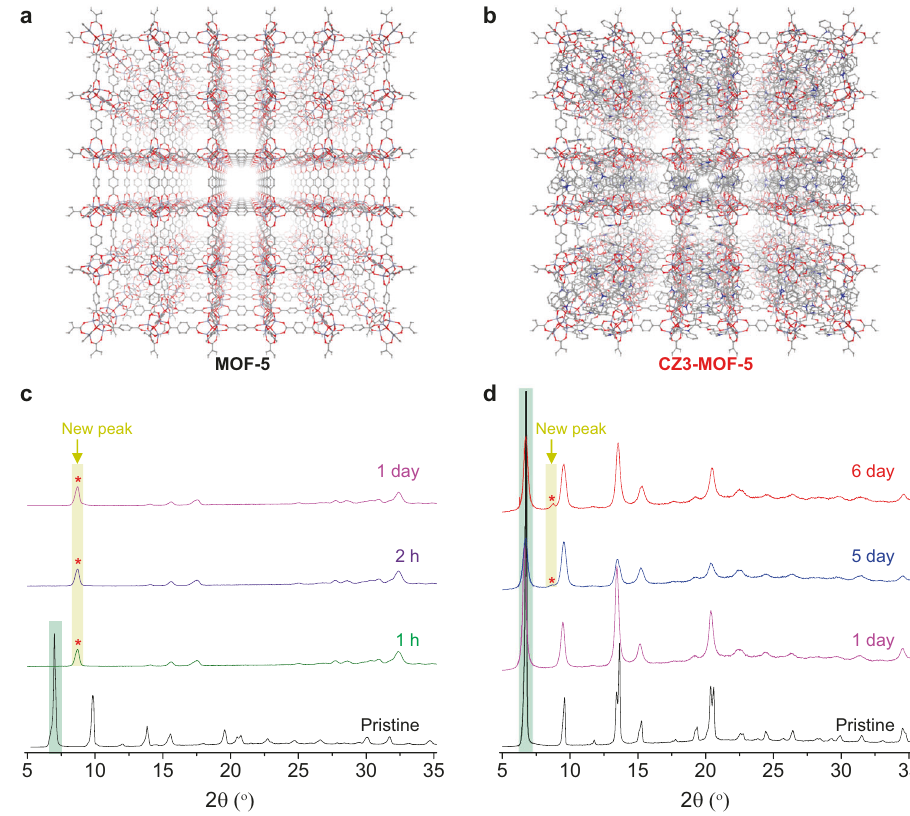
Fig. 5 Hydrolytic stability with respect to the exposure time to steam at 90 °C. Perspective views of a MOF-5 and b CZ3-MOF-5 in the supercell (3 × 3 × 3). PXRD patterns of c MOF-5 and d CZ3-MOF-5. The asterisk and yellow marks highlight the appearance of a peak at about 8.8° due to the phase transformation of MOF-5 to